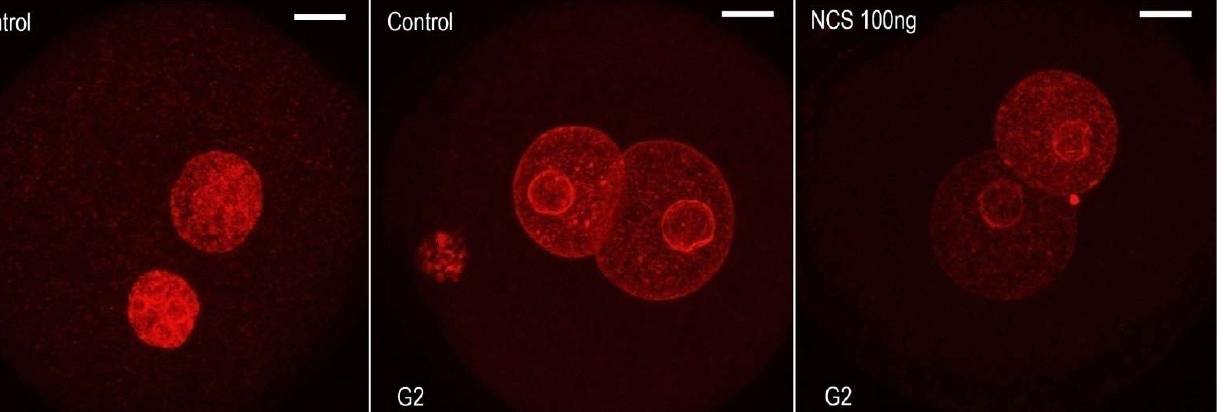
Figure 6. Quantification of the total volume of DNA in control and NCS-treated one-cell embryos. The graph shows the relativized values of the measured fluorescent signal densities. 2.5. DNA Damage CanInduce Chromosomal Missegregation For monitoring the progress of nuclear envelope breakdown (NEBD), the chromosomes alignment during metaphase, and the anaphase in the one-cell embryo stage and during the formation of nuclei in the early two-cell stage, we applied time-lapse microscopy after the microinjection of an H2B-EGFP mRNA construct. Both the control and NCS-treated embryos formed correct chromosomes´ alignment in the metaphase in the same time period. Chromosomal segregation errors were more often visible in NCS-treated embryos during the prometaphase and metaphase. These chromosomal fragments were localized outside of the metaphase plate and persisted until the anaphase stage of the first cell cleavage (Figure 7 and Supplementary Data, Movie S1). As analyses revealed, the frequency of the chromosome segregation problems depended on the concentration of NCS applied in the G1-phase (Figure 8). Thus, segregated chromatin structures were also observed outside of the new formed nuclei in two-cell embryos.